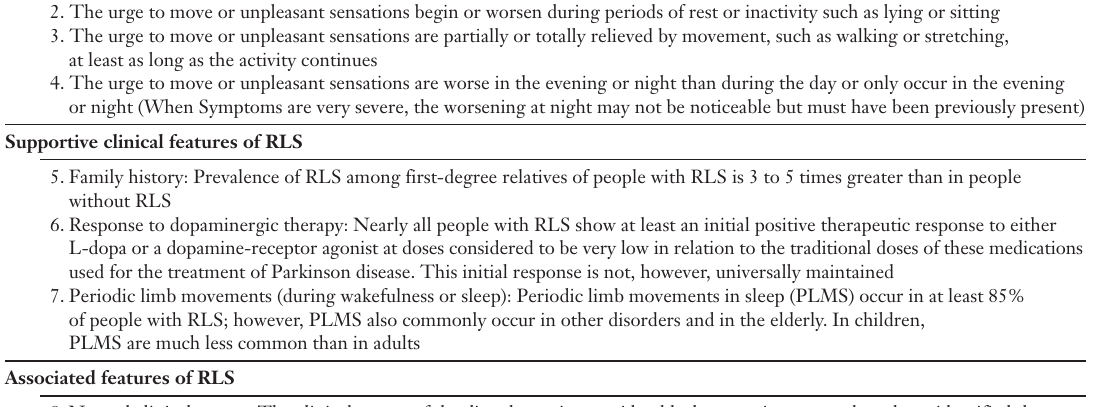
Diagnostic criteria (adapted from